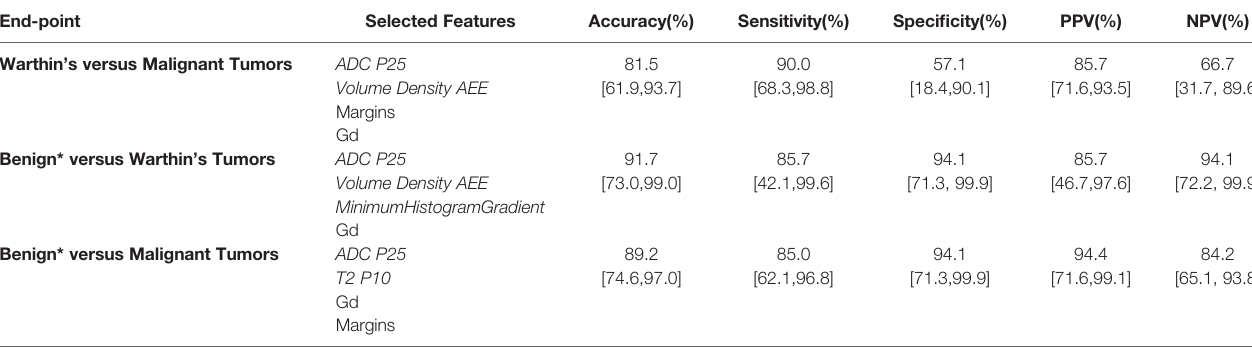
TABLE 4 | Predictive Performance of the three models tested on the validation cohort.